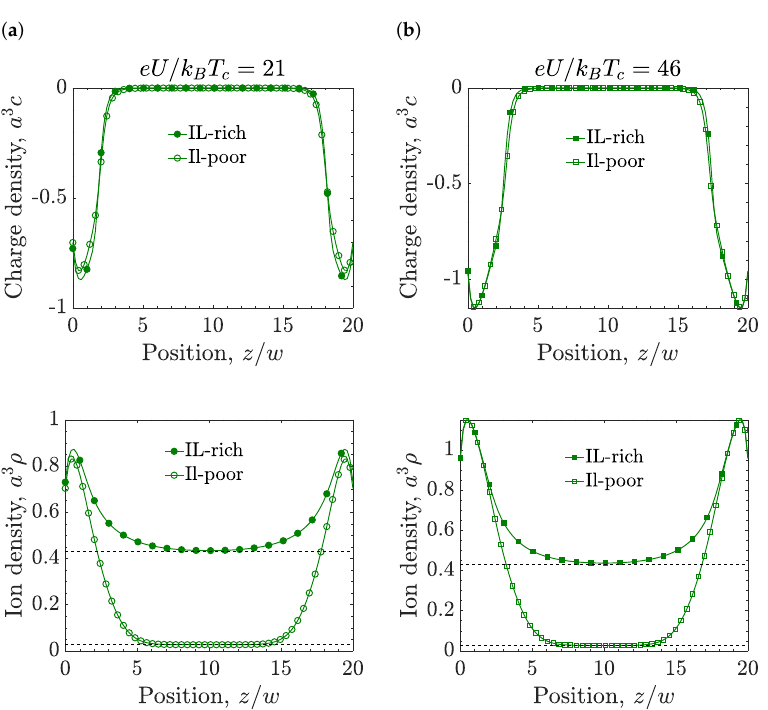
Figure 8. Charge and ion density profiles at the capillary ionization transition. ( a ) Charge and ion density profiles at eU / k B T c = 21. ( b ) Charge and ion density profiles at eU / k B T c = 46. In all the plots, the chemical potential µ / k B T c = − 4.57, the temperature T / T c = 0.838, slit width w = 20 a , and ionophilicity a 3 h s / ξ 0 = 0.25, where ξ 0 is the bare correlation length and a the ion diameter. The dashed horizontal lines show the bulk values in the corresponding phases. The filled symbols represent the IL-rich phase while the unfilled symbols denote the IL-poor